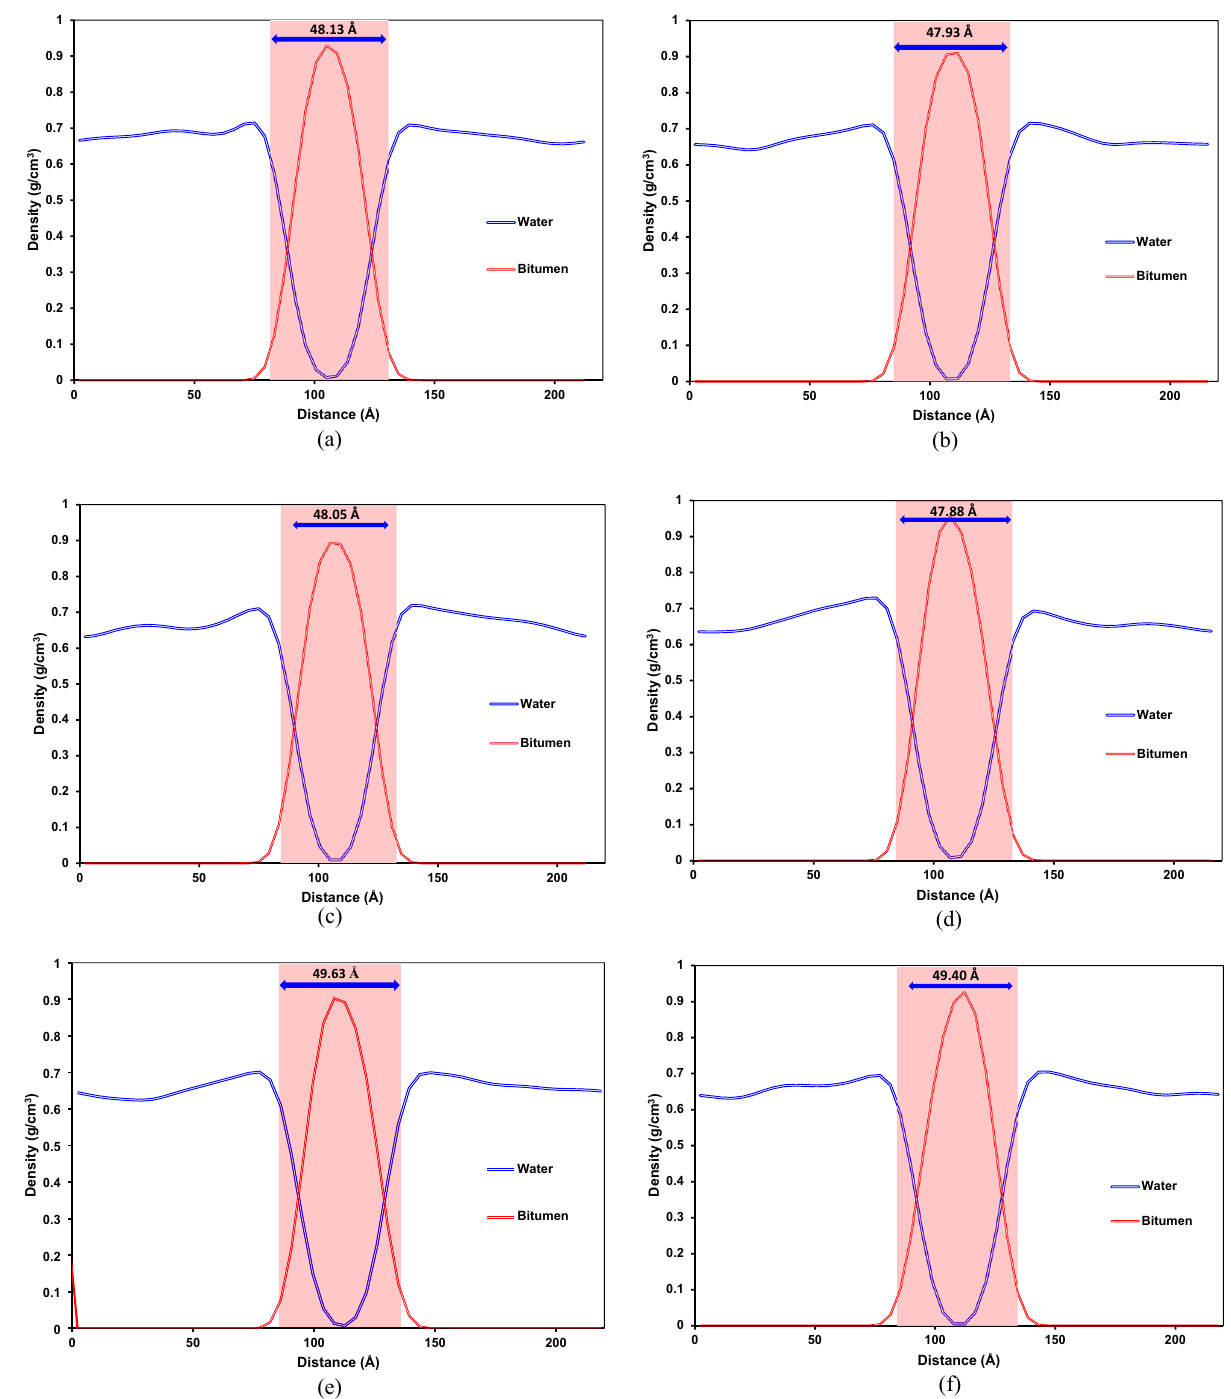
Figure 19. Comparison between interfacial thickness between the aqueous phase and bitumen droplets for the system: ( a ) SB-AA, ( b ) SB-AB, ( c ) S-AA, ( d ) S-AB, ( e ) SB-BA, ( f ) SB-BB, ( g ) S-BA, ( h ) S-BB, ( i ) W-AA, ( j ) W-AB, ( k ) W-BA, and ( l )